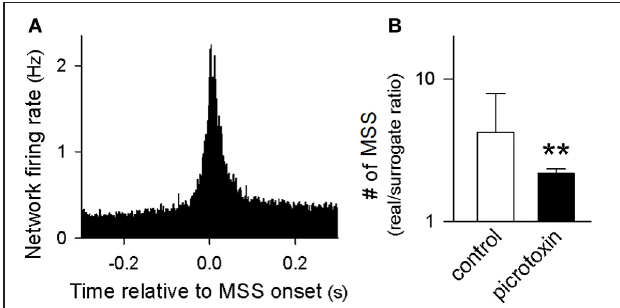
FIGURE 9 | Mechanisms of MSSs. (A) Peri-MSS time histogram of the mean firing rates of all neurons monitored in 9 videos. The firing rates were aligned at the time relative to the onset of 27,804 individual MSSs. (B) The number of MSSs relative to chance were decreased by bath application of 50 µ M picrotoxin. ∗∗ P < 0 . 01 versus control, Student’s t -test. The data are the mean ± SDs of 9 videos.